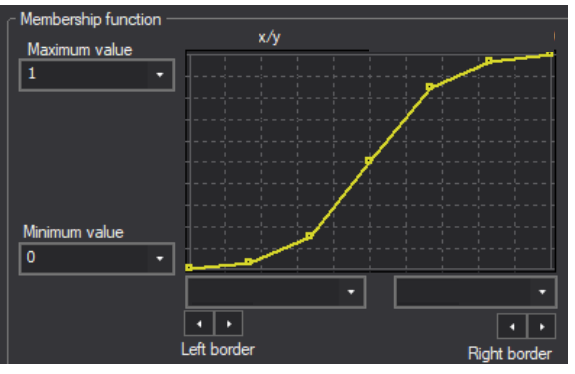
Figure 8. First membership function (F1).